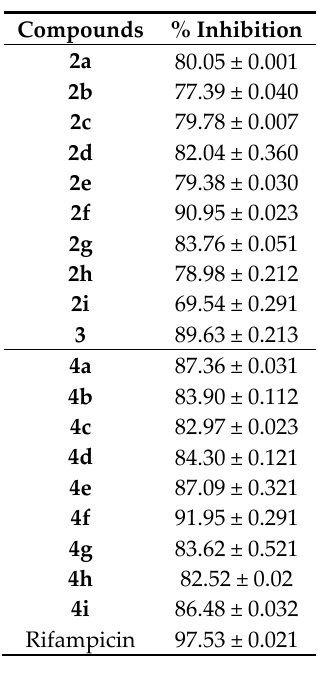
Table 6. Biofilm inhibition assay of the compounds ( 2a – 2i , 3 and 4a – 4i ) at a concentration of 50